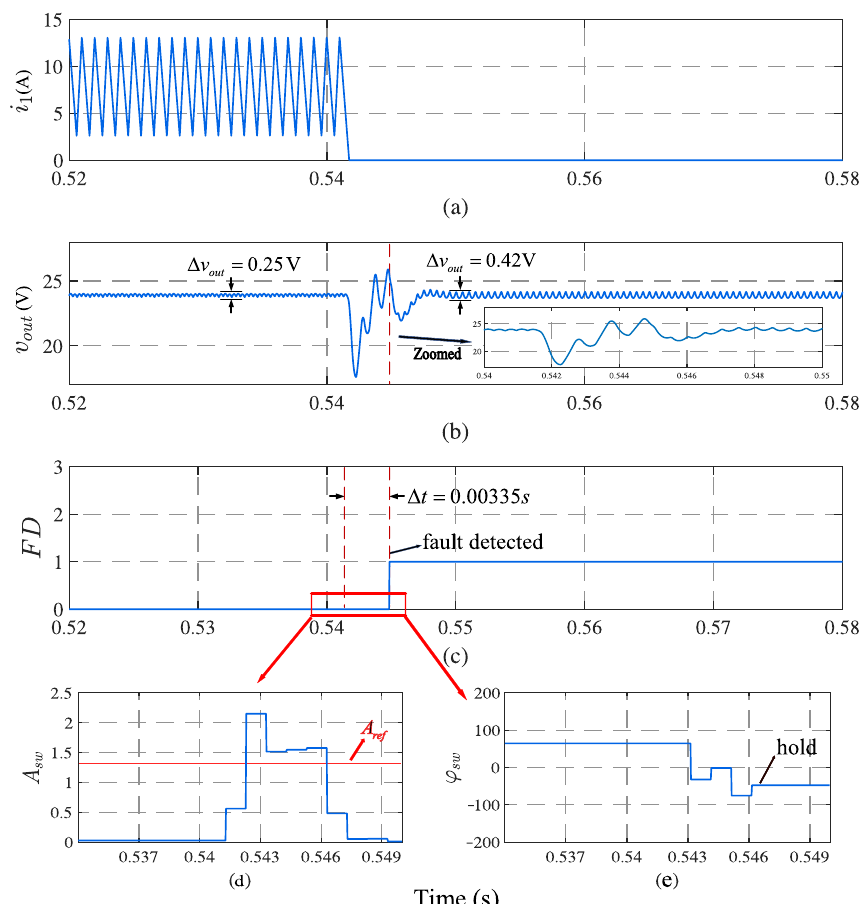
Figure 9. Waveforms after an OCF in branch 1 with the proposed method: ( a ) branch 1 current, ( b ) the output voltage at load side, ( c ) instantaneous state FD corresponding to OCF, ( d ) A sw of the output voltage, and ( e ) ϕ sw of the output